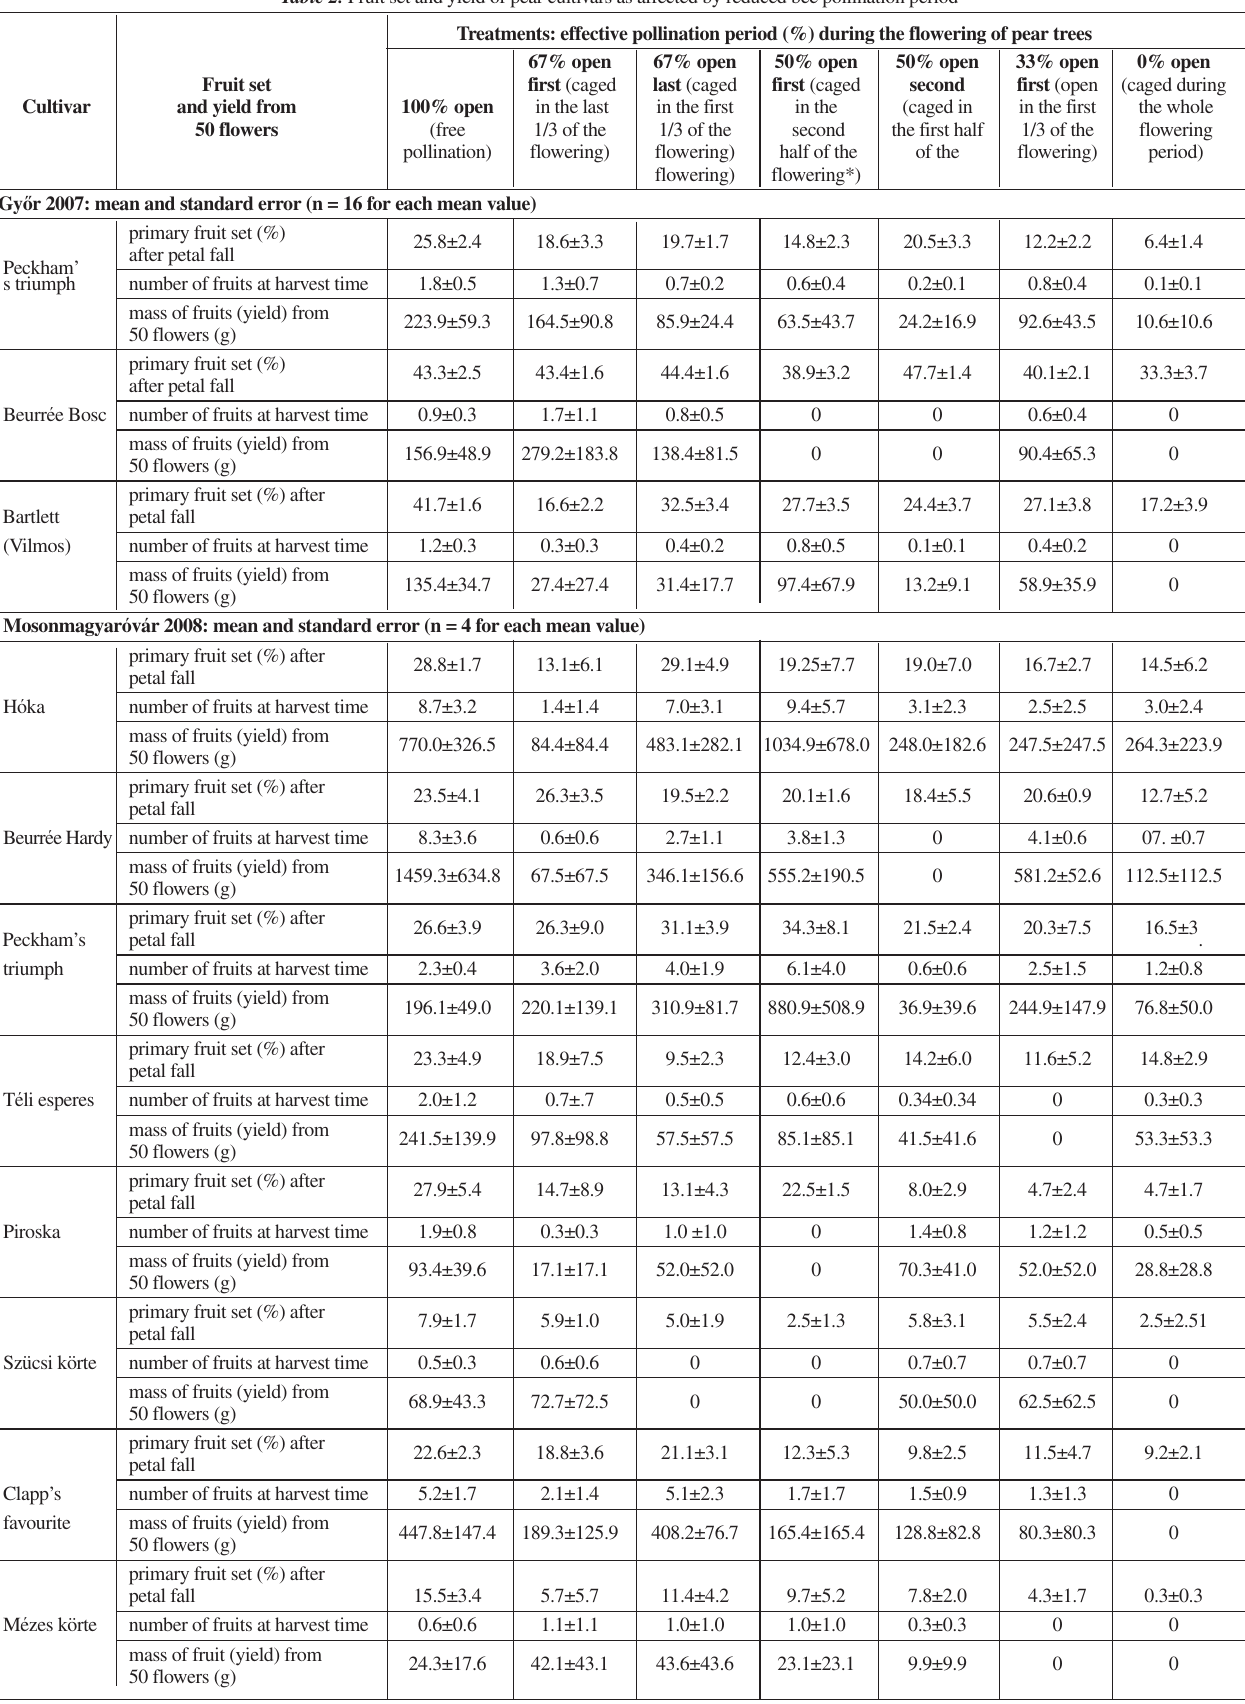
Table 2. Fruit set and yield of pear cultivars as affected by reduced bee pollination period Treatments: effective pollination period (%) during the flowering of pear trees 67% open 67% open 50% open 50% open 33% open 0% open Fruit set first (caged last (caged first (caged second first (open (caged during